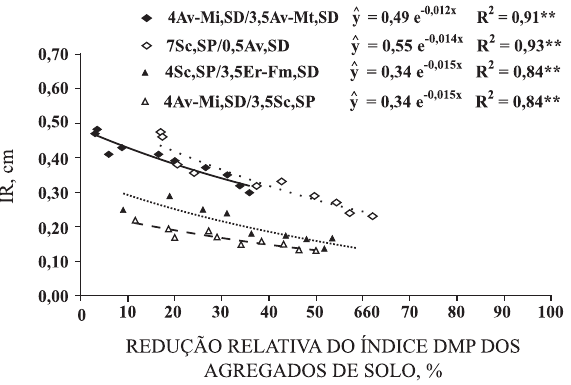
Figura 3. Relação do índice IR da rugosidade superficial do solo criada pelo preparo com a redução relativa percentual (base de massa) do diâmetro médio ponderado (DMP) dos seus agregados nas sequências culturais estudadas (obs.: resultados relativos aos testes de erosão com chuva simulada T3 a T7; em cada um o solo se apresentava mobilizado com grade leve e